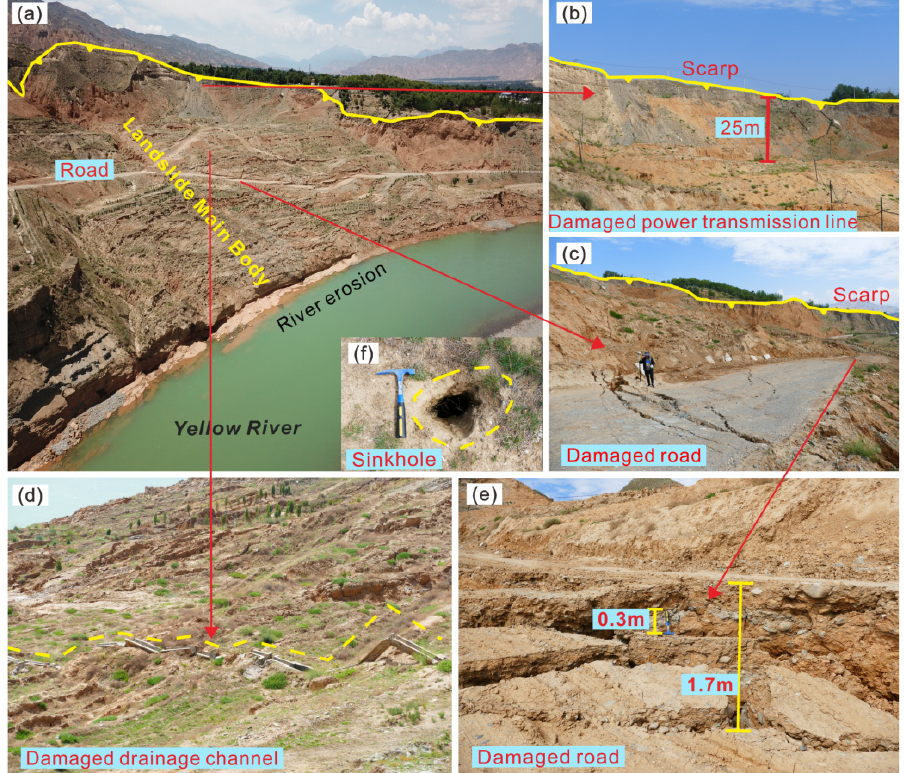
Figure 3. Field investigation of the Simencun landslide: ( a ) Landslide’s main body, ( b – e ) damaged public facilities and ( f ) sinkhole.